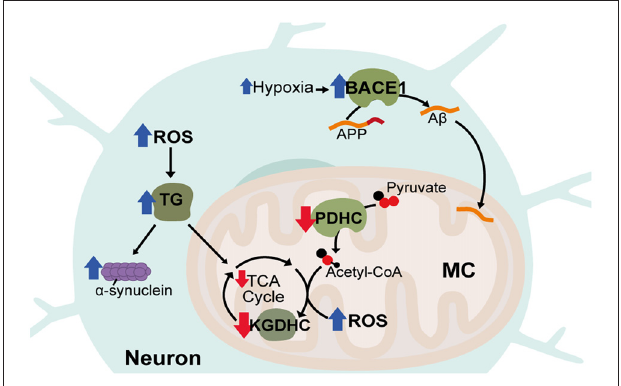
FIGURE 3 | Disrupted metabolic pathways in neurodegenerative diseases. Hypoxia associated with Alzheimer’s Disease (AD) leads to increases in the HIF-1 α target, β -site β -amyloid precursor protein cleavage enzyme 1 (BACE1), which cleaves amyloid precursor protein (APP) to produce A β . A β accumulates in neuronal mitochondria (MC) early in disease progression and disrupts oxidative metabolism. Acetyl-CoA production and tricaboxcylic acid (TCA) cycle entry is decreased in AD through reduced activity of the pyruvate dehydrogenase complex (PDHC). In all three diseases, activity of α -ketoglutarate dehydrogenase complex (KGDHC) is reduced, reactive oxygen species (ROS) is increased and transglutaminase (TG) activity is increased. TG increases α -synuclein aggregation and reduces oxidative